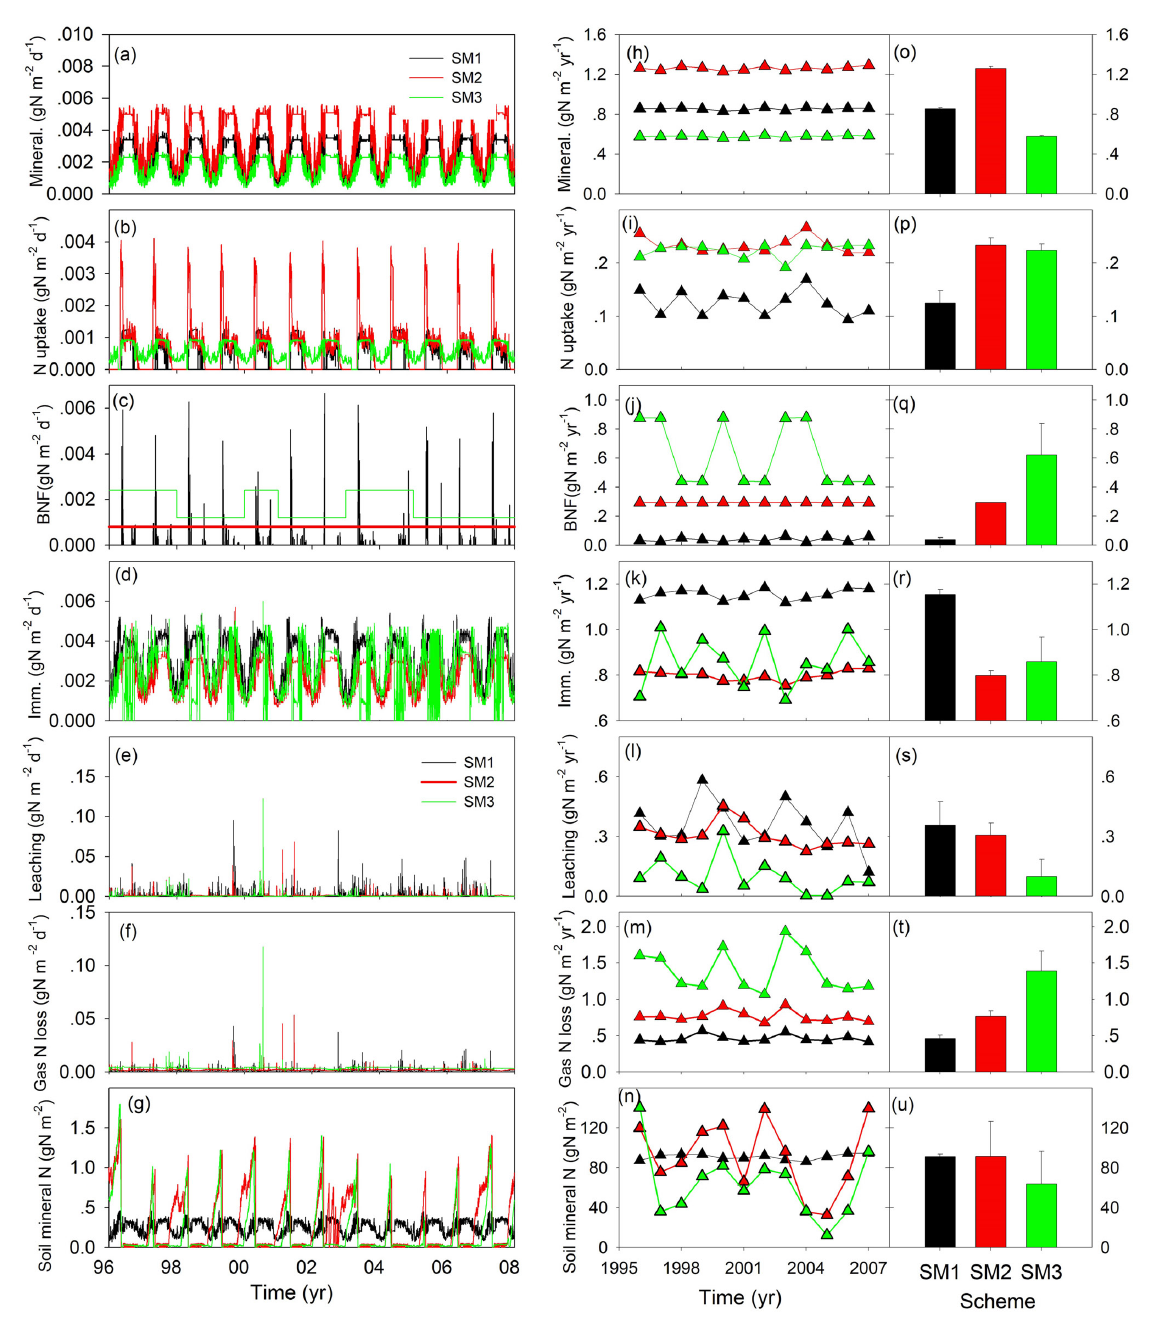
Figure 3. Simulated nitrogen fluxes and soil mineral nitrogen from three carbon–nitrogen coupling schemes (SM1, SM2, and SM3) in the TECO-CN model for 1996 to 2007 at Duke Forest. Mineral.: mineralization; BNF: biological N fixation; Imm.: immobilization.